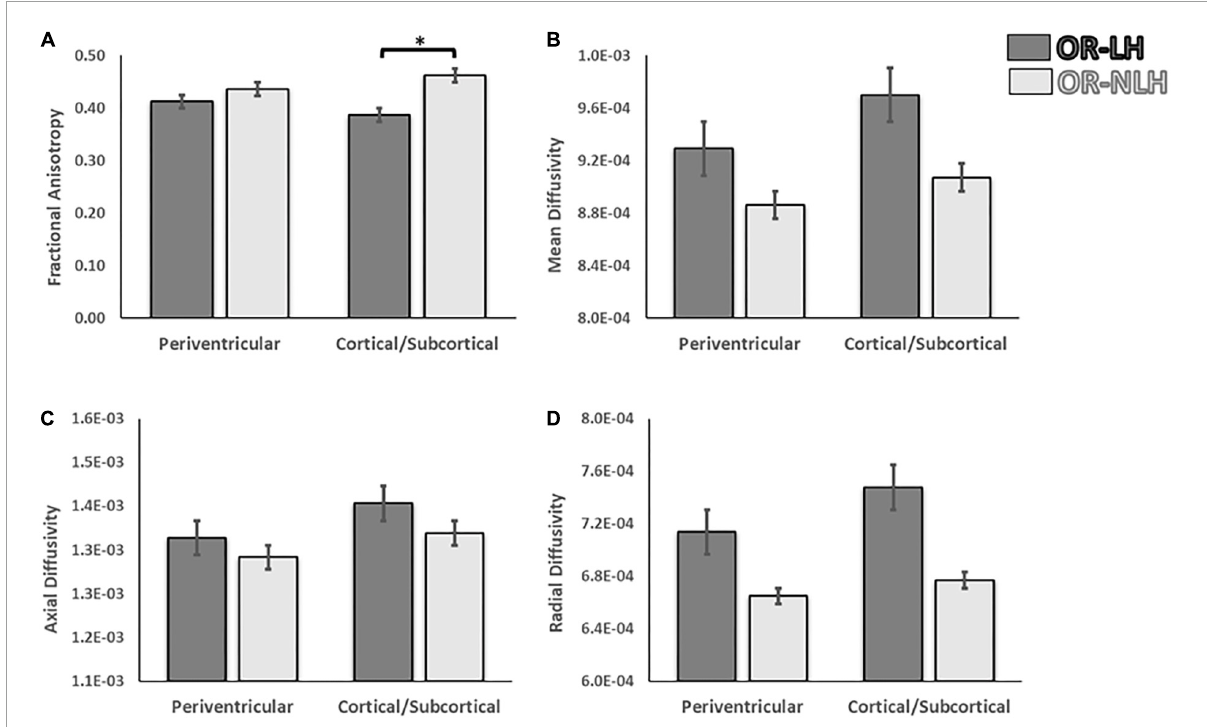
FIGURE4 Differences in white matter integrity of the OR of the lesional and non-lesional hemispheres as functions of lesion type in children with USCP. (A) Fractional anisotropy, (B) mean diffusivity, (C) mean axial diffusivity and (D) mean radial diffusivity. OR-LH, optic radiation of the lesional hemisphere; OR-NLH, optic radiations of the non-lesional hemisphere. Error bars represent standard errors of the mean. ∗ p <